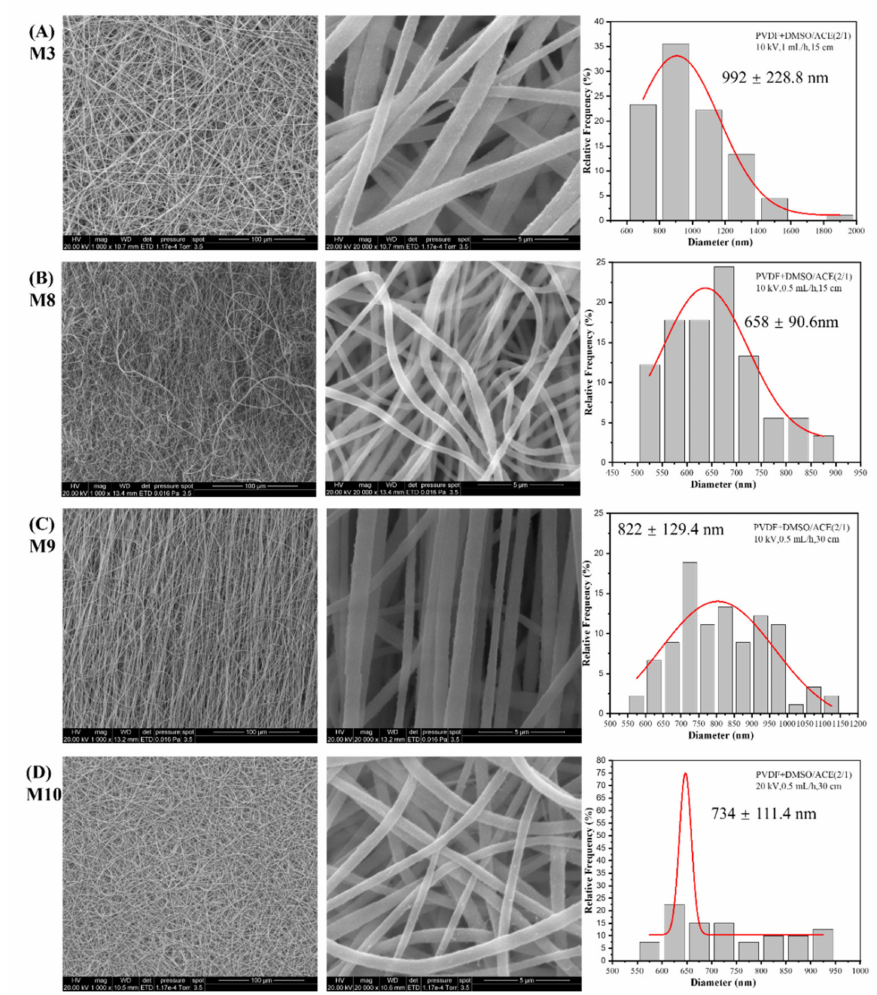
Figure 7. SEM images at two magnifications and the diameter histogram of PVDF nanofibrous membrane ( A ) M3 (using 10 kV, 1 mL/h, 15 cm), ( B ) M8 (using 10 kV, 0.5 mL/h, 15 cm), ( C ) M9 (using 10 kV, 0.5 mL/h, 30 cm), and ( D ) M10 (using 20 kV, 0.5 mL/h, 30